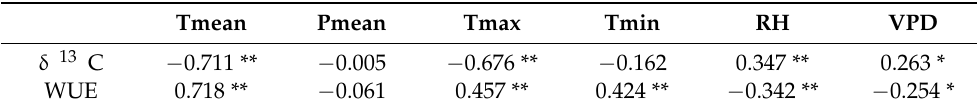
Table 1. The relationship between δ 13 C and WUE of Picea meyeri and annual meteorological factor on Luya mountain. Figure 7. Correlations between δ 13 C of Picea meyeri and monthly meteorological factors on Luya mountain (c represents the current year and p represents the previous year; * and ** symbol repre- sent signi fi cant correlation at the 0.05 and 0.01 level, respectively).